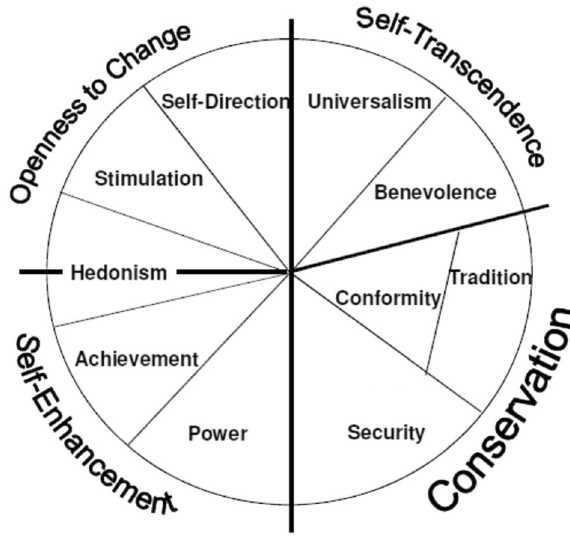
Fig. 1 The value model of Schwartz (2012). The circular structure describes relations of con fl ict and congruity among ten basic values resulting in four higher-order